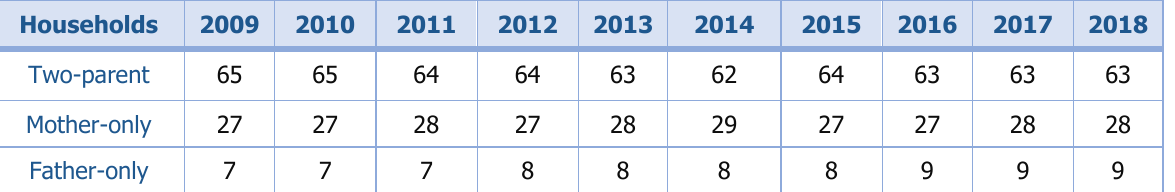
Table 2. Percentages of Ohio Households Led by Two Parents or Single Parents